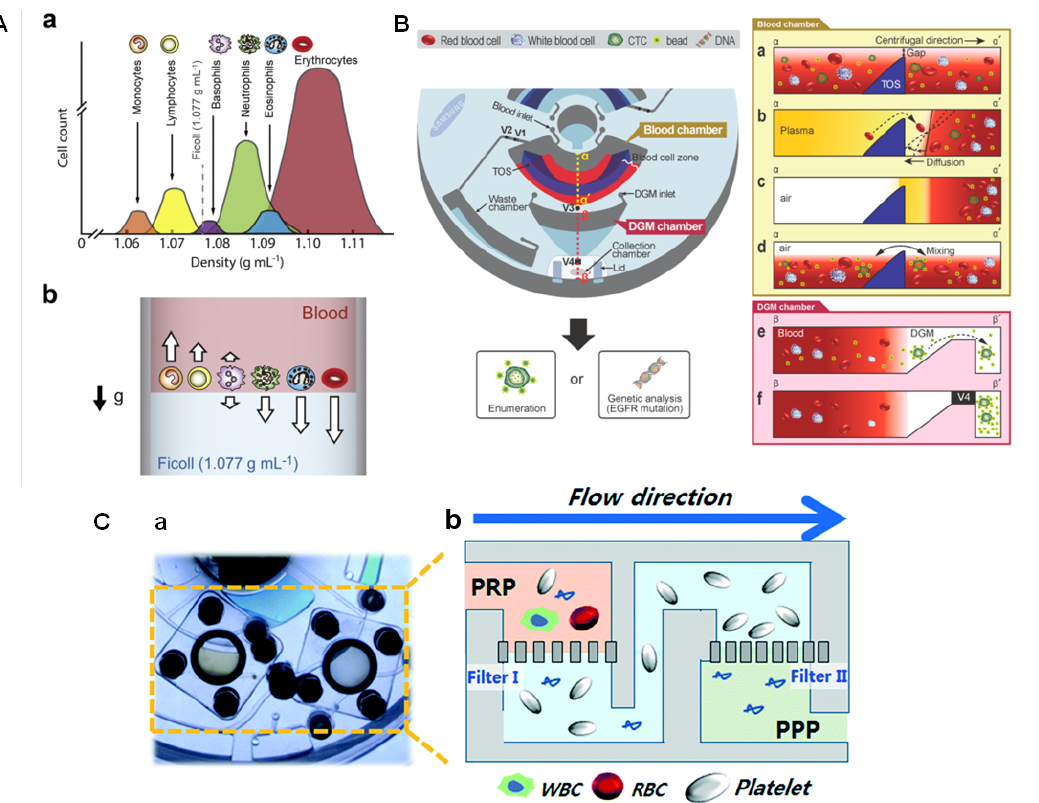
Figure 6. ( A ) Sorting of blood cells based on the DGM centrifugation. ( a ) The density distribution of human blood cells and ( b ) the movement of blood cells upon centrifugation with blood layer placed on the top of the Ficoll solution. The arrows indicate the movement direction of cells. Reproduced from [109] with permission from Elsevier. ( B ) Disc design for sorting CTCs from whole blood. TOS: triangle obstacle structure; V1, V2, V3, and V4 are on/off operation valves (wax that changes from liquid to solid state) controlled by laser irradiation. ( a ) Cross-sectional view of the blood chamber after injection of blood and microbeads; ( b ) after plasma separation; ( c ) after removal of the plasma with opening V1; ( d ) during incubation to bind CTCs to the antibody-functionalised beads; ( e ) the cross-sectional view of the DGM chamber showing that only CTC-microbead complexes (with higher density than DGM) are moved to the collection chamber; ( f ) V4 is closed to prevent sample contamination during collection. Reprinted with permission from [104]. Copyright 2014 American Chemical Society. ( C ) Filtration-based platelet isolation disc: ( a ) photograph and ( b ) schematics. Filter-I to eliminate both white blood cells and red blood cells from a platelet-rich-plasma (PRP). PRP runs through Filter-II which captures platelets while washing platelet-poor plasma (PPP) out to the waste chamber. Reproduced from [117] with permission from The Royal Society of